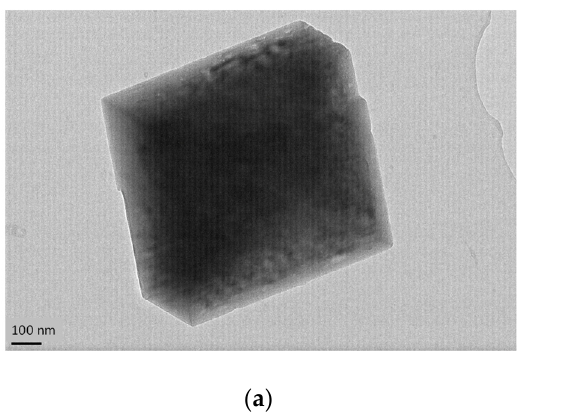
( b ) Figure 7. ( a ) TEM image of sample 01-contactor depicting a cubic single calcite particle and ( b ) the respective cubic dif- fraction pattern.